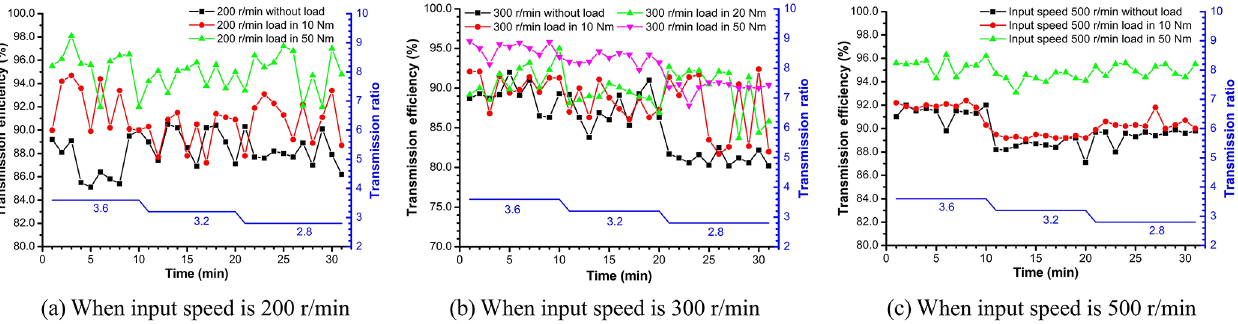
Figure 5. Transmission efficiency of different acceleration process with various loading.